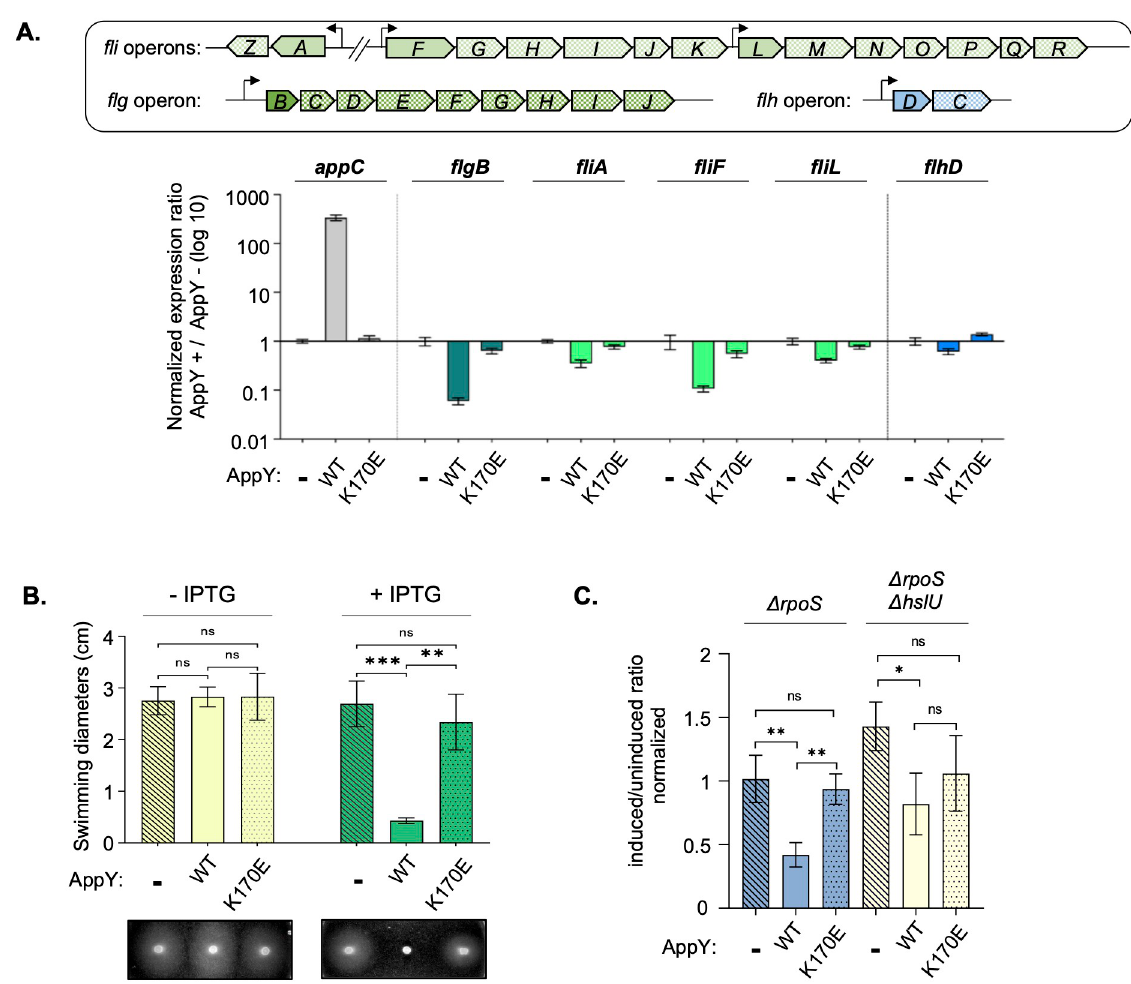
Fig 6. AppY indirectly reduces bacterial motility. A. Expression of flagellar genes is down-regulated by AppY overproduction. MG1655 Δ rpoS strain was transformed with the pQE80L empty vector (-) or containing appY (WT) or appY mutant (K170E). Cultures were grown to OD 600 * 0.5 and induced with 1 mM IPTG for 1 hour. RNAs were extracted from 10 9 cells and qRT-PCR experiments were performed. The genetic organization of flagellar genes is shown above the graph. Expression of the first gene of each operon (plain colour) was tested ( fliALF in green, flgB in dark green, flhD in blue); appC (grey) is a control. Data are means +/- standard deviation (n = 3). B. AppY overproduction affects motility. ON cultures were adjusted to OD 600 = 1 and 1 μ l was spotted on plates without (light green) or with IPTG (green). Plates were incubated at 30˚C during 15 to 20 h and swimming diameters were measured. A representative picture of swimming is shown below the graph. Statistical significance calculations were performed using a two-tailed unpaired Student’s t test (ns, not significant; �� , p-value < 0.01; ��� , p-value < 0.001). C. AppY favors FlhC degradation by the HslUV protease. MG1655 Δ rpoS (blue) and MG1655 Δ rpoS Δ hslU (yellow) strains containing flhC -SPA on the chromosome were transformed with the pQE80L empty vector (-, hatched) or containing appY (WT, plain) or appY mutant (K170E, dotted). Cultures were grown to an OD 600 * 0.6 and induced with 1 mM IPTG at 37˚C for 1 hour. FlhC levels were analysed by Western blotting using anti-Flag antibody. HtpG was detected as a loading control. Each value obtained for FlhC has been normalized on the loading control. Then the “Induced” samples were divided by the “Uninduced” samples for each condition. Statistical significance calculations were performed on these data using a two-tailed unpaired Student’s t test (ns, not significant; � , p-value < 0.05; �� , p- value <